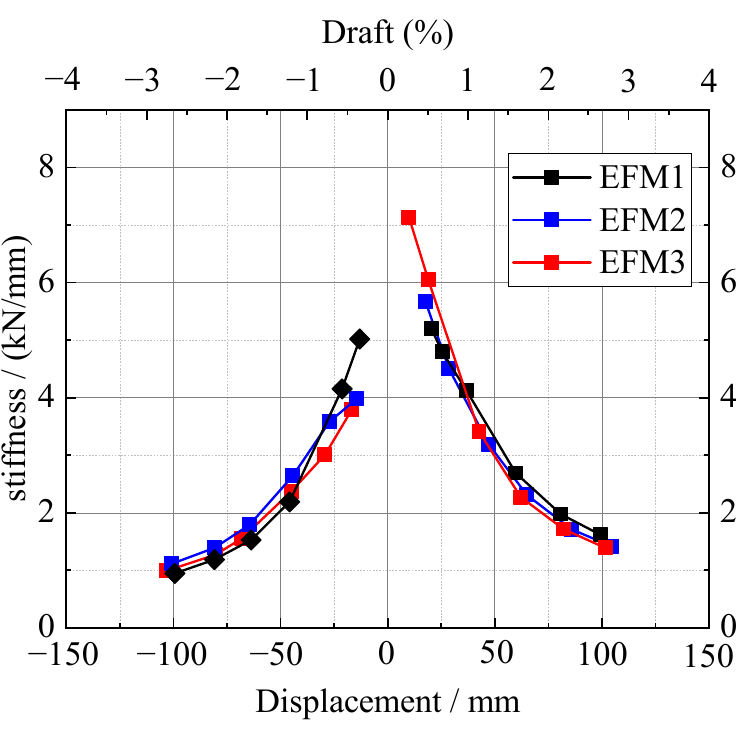
Figure 31. Stiffness degradation curves for different axial compression ratios.